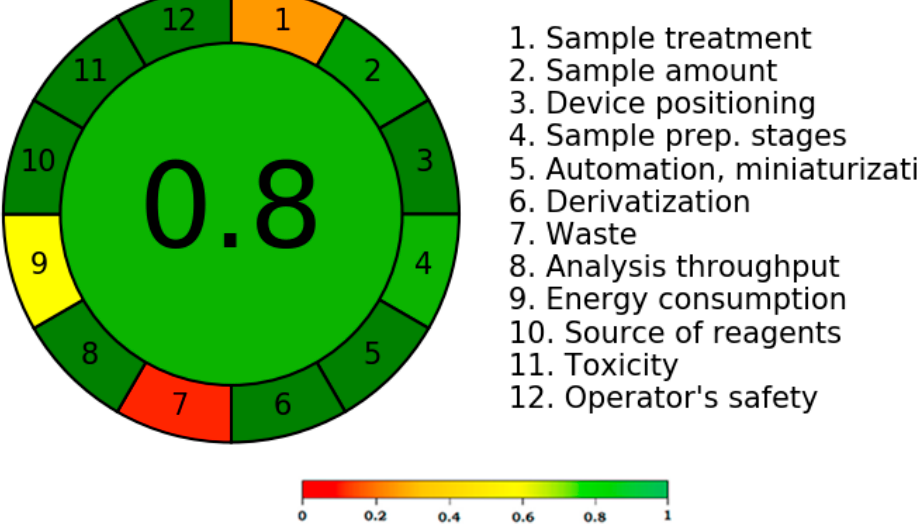
Figure 6. A typical pictogram for AGREE score for the present approach obtained utilizing AGREE Figure 6. calculator.